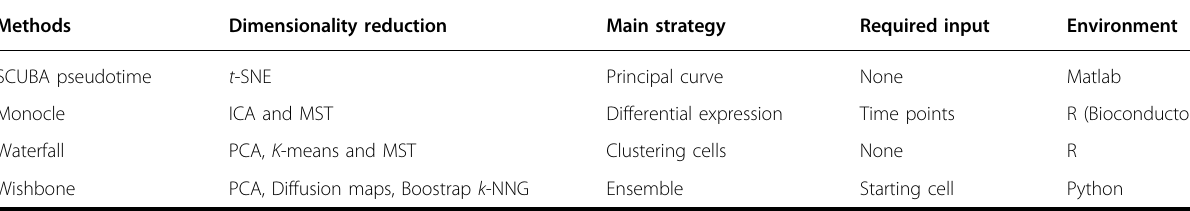
Table 2 Comparison of trajectory inference methods using scRNA-seq